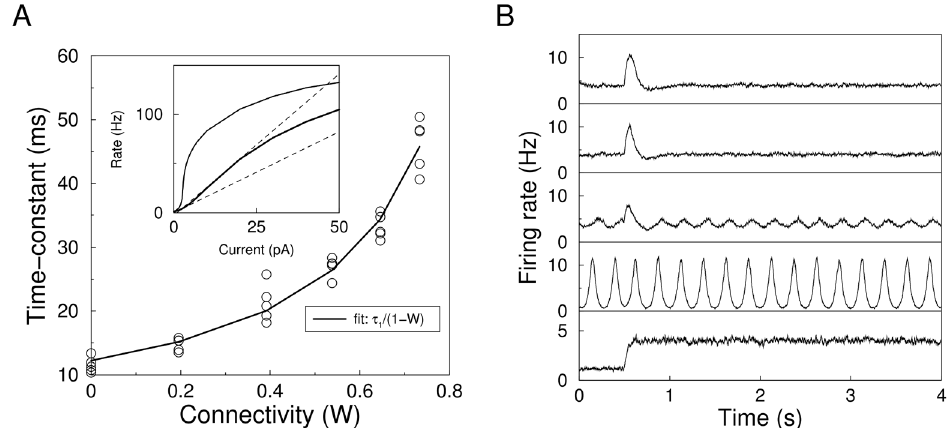
Fig 4. Homeostatic regulation in a network of integrate-and-fire neurons. A) The effective time-constant of the network as a function of recurrent connection strength. Circles denote simulation results and the curve is the fitted relation τ 1 /(1 − w m ). Inset shows the f-I curve of the unconnected network (lower curve), the slope at the set-point (lower line) and slope of the envelop (upper line). F-I curve of the connected network (upper curve) is shown for comparison. B) Example population response to step stimuli for varying values of τ 3 corresponding to, from top-to bottom: τ 3 = 380ms (stable according to Aizerman criterion); τ 3 =